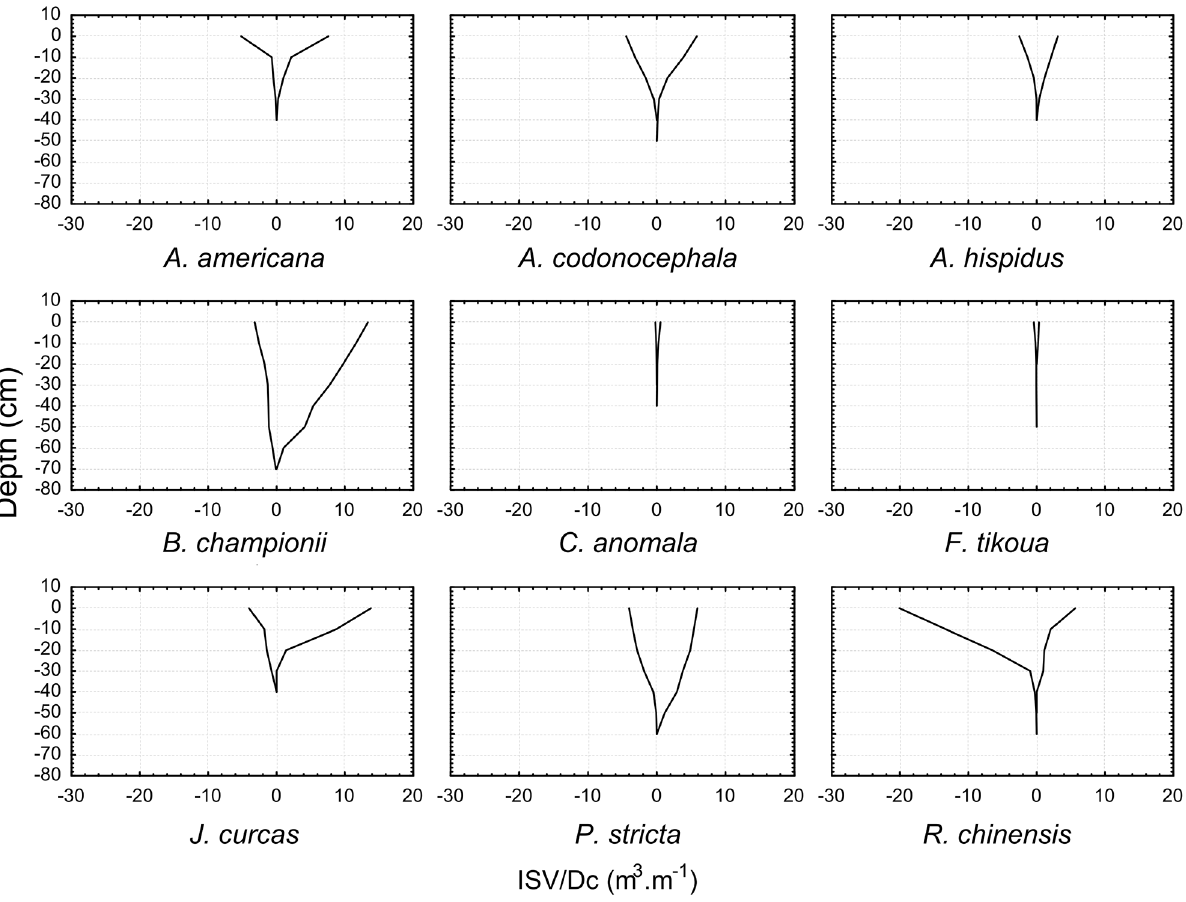
Figure 5. Mean individual soil volume standardized by collar diameter (ISV/Dc). Negative values of ISV/Dc represent downslope